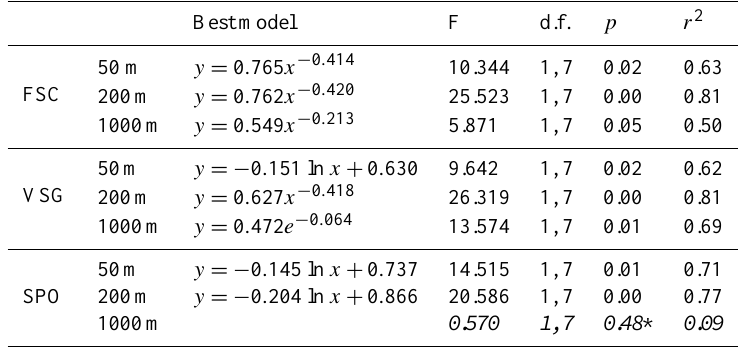
Table 3. Results from regression analyses of FSC, VSG, and SPO against Fpw at each of the three window sizes. ∗ and italics indicate no significant relationship.